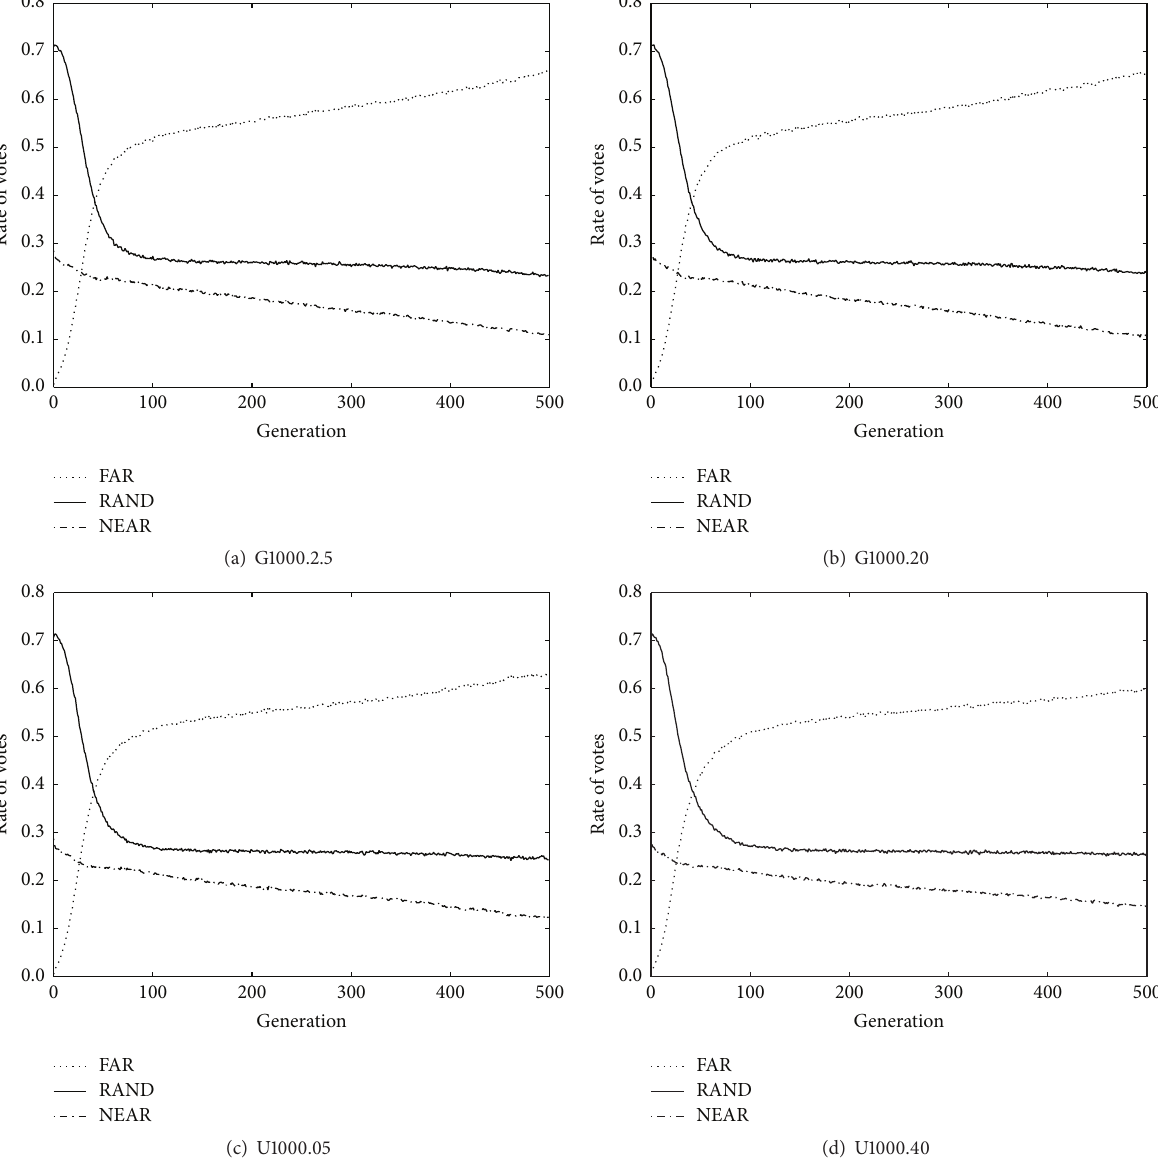
Figure 6: Voting rates of schemes in graph